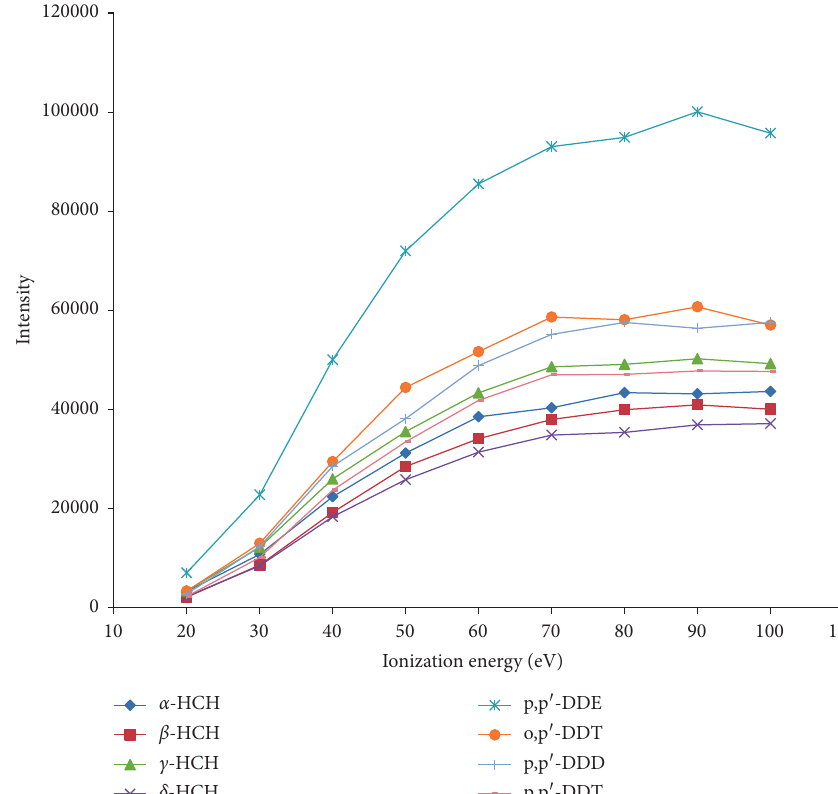
Figure 3: Absolute intensity of chloride ionized at different ionization energy values for eight organochlorine pesticides: α -hexa- chlorocyclohexane ( α -HCH), β -hexachlorocyclohexane ( β -HCH), c -hexachlorocyclohexane ( c -HCH), δ -hexachlorocyclohexane ( δ -HCH), 1-chloro-2-[2, 2, 2-trichloro-1-(4-chlorophenyl) ethyl] benzol (o, p ′ -DDT), 2, 2-bis ( p -chlorophenyl)-1, 1, 1-trichloroethane ( p , p ′ -DDT), 2, 2-dichloro-1, 1-bis (4-chlorophenyl) ethylene ( p , p ′ -DDE), and 1, 1-dichloro-2, 2-bis ( p -chlorophenyl) ethane ( p , p ′